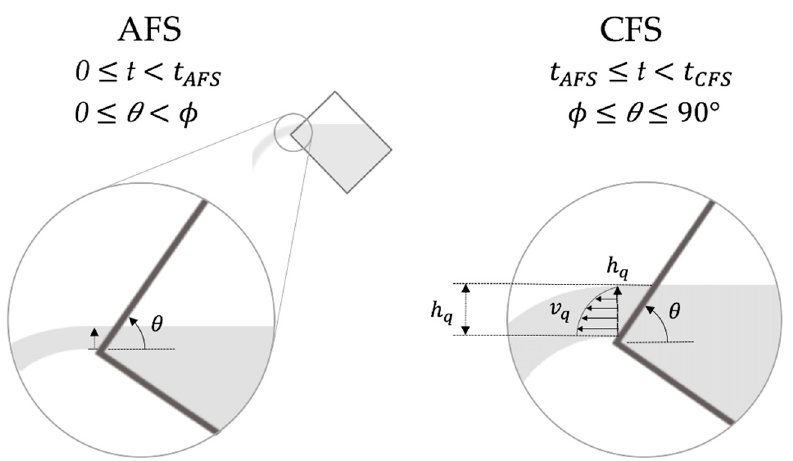
Figure 3. Stages of pouring. To the ( left ), the approaching flow stage (AFS) going from the initial time to t AFS . To the ( right ), the succeeding stage of constant flow (CFS) going from t AFS to t CFS .